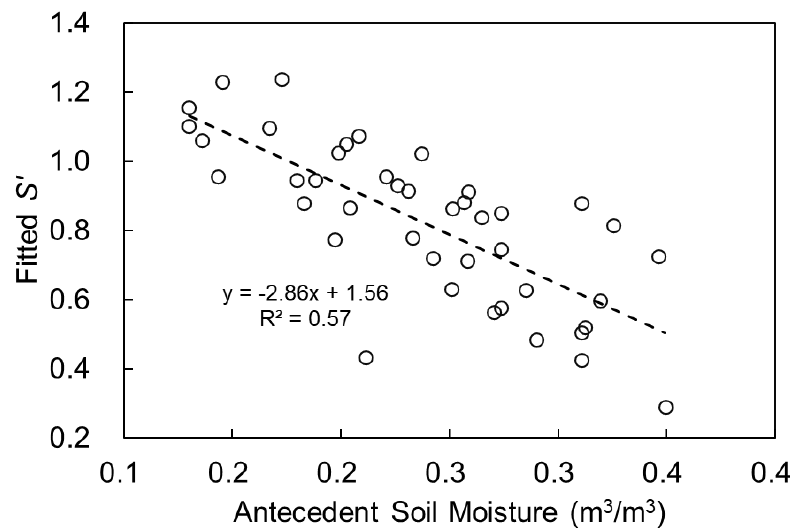
Figure 7. Linear correlation between the parameter S ′ and measured initial soil moisture (each circle corresponds to an experimental scenario).